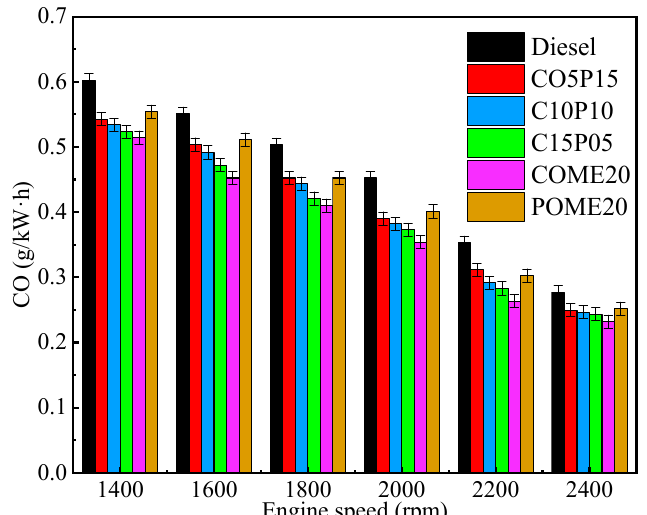
Figure 21. CO emission comparison of COME and POME biodiesel blends at different engine speeds [222].